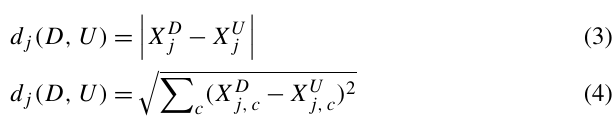
each model parameter is regionalised independently of an- other, based on their spatial correlation. Catchment position is defined by the coordinates of the catchment centroid and the ordinary kriging is based on an exponential variogram with a nugget of 10 % of the observed variance, a sill equal to the variance, and a range of 60 km for both TUW and CemaNeige–GR6J model